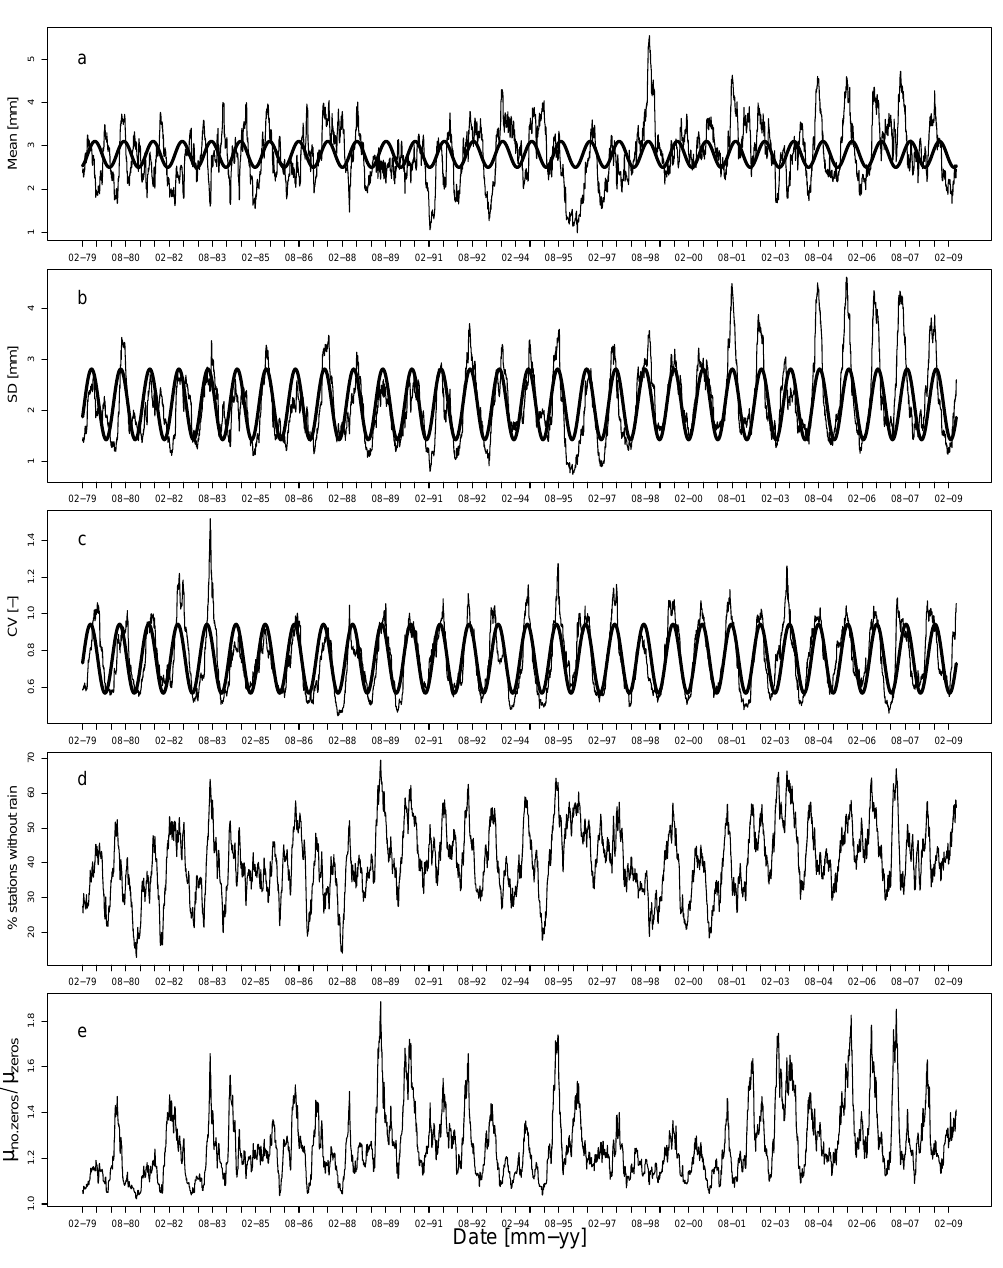
Fig. 4. Temporal variation of rainfall spatial statistics, determined using a 90-day moving window. (a) is the 90-day moving average of the daily rainfall sum. (b) is the average standard deviation for a 90-day moving window. (c) is the coefficient of variation. Bold lines are cosines fitted through the data. (d) is the 90-day moving average of the percentage of dry stations. (e) is the ratio of the mean without dry stations and the mean with dry stations